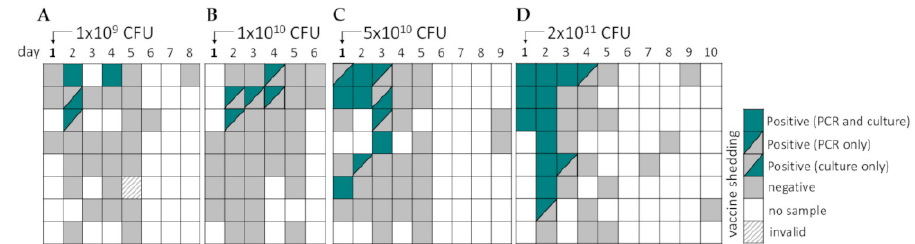
Figure 2. Vaccine shedding in stool after single oral vaccination with ShigETEC. Stool samples were obtained as available from subjects who received a single oral immunization with ( A ) 1 × 10 9 CFU, ( B ) 1 × 10 10 CFU, ( C ) 5 × 10 10 of ( D ) 2 × 10 11 CFU ShigETEC and assessed for the presence of vaccine strain by PCR and culturing. PCR was considered invalid, when two independent 16S rDNA PCR assays yielded negative results and repeated DNA extraction was not possible due to small sample amount. Each line corresponds to one